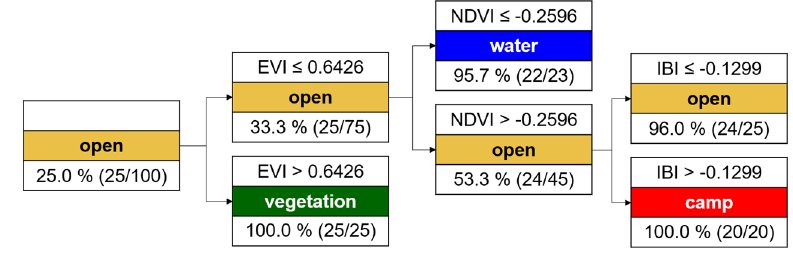
Figure A9. CART for July 2018.